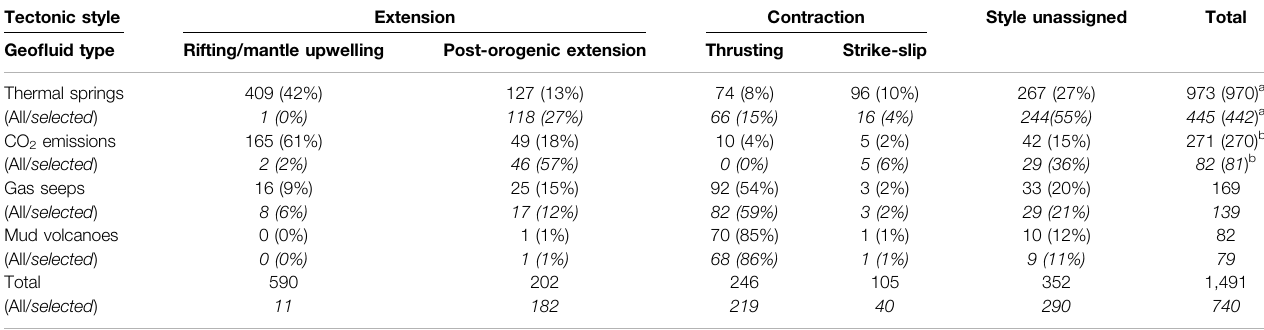
TABLE1| Summaryofthedistributionofgeo fl uidemissionscollectedforthispaperinthefourtectonicdistrictsdiscussedin SelectingtheTermsofComparison Section. For each emission type the fi rst line reports all available data, whereas the second line (in italics) reports only the data left following the selection discussed in the Selecting the Terms of Comparison Section. Numbers in parentheses indicate the % of each type of emissions falling in each tectonic district, relative to the total (last column to the right). Notice that some datapoints were deliberately double-counted as they fall in overlapping